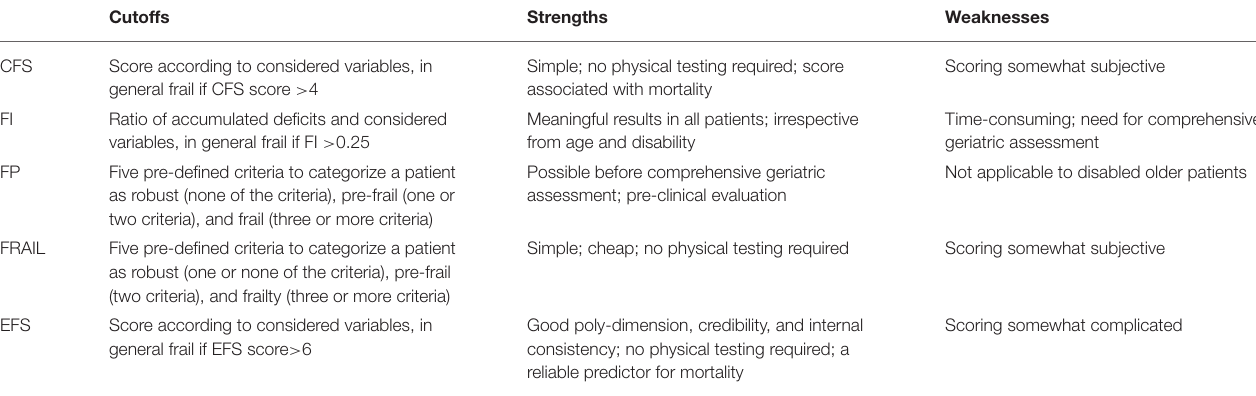
TABLE 1 | Performance of different evaluation methods to identify frailty among patients with COVID-19.